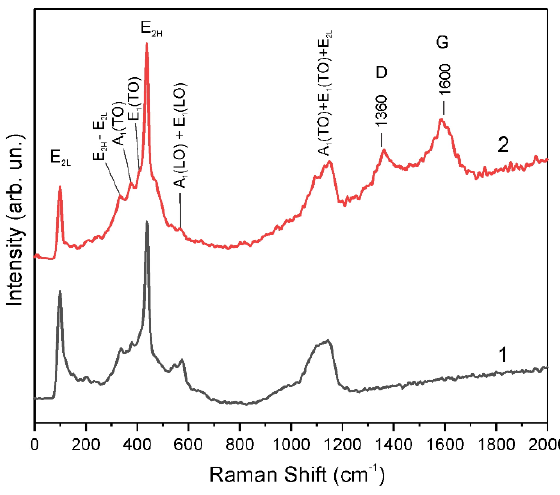
Figure 7. Raman spectra of two ZnO films simultaneously treated in hydrogen plasma for 3 min: 1) P-sample, 2) A + P sample.